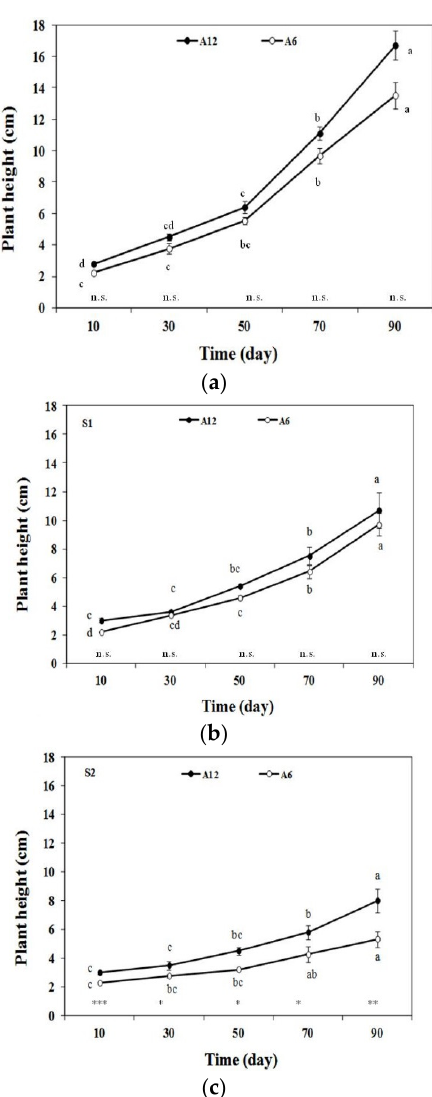
Figure 2. Tree height (cm) every 20 days in response to different salinity levels (S0, S1, and S2) of two accessions A6 and A12. a–c: the letters on the lines denote statistically significant differences among growth times for each accession ( p = 0.01; SNK test); the stars denote statistically significant differences between the two accessions for each growth time (* p = 0.05; ** p = 0.01; *** p = 0.001; n.s. not significant; t ‐ test). ( a ) represents the plant height under treatment S0, ( b ) represents the plant height under treatment S1, ( c ) represents the plant height under treatment S2.